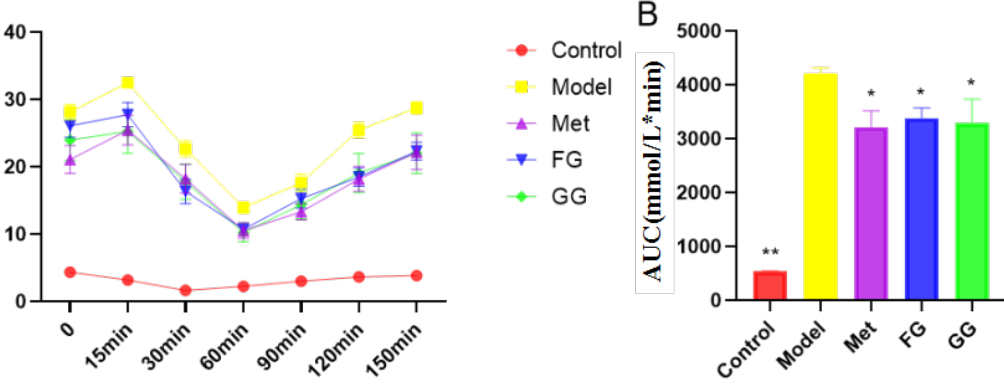
Figure 2. Effects of Pueraria polysaccharide on the glucose tolerance of db/db mice ( n = 10; * p < 0.05; ** p < 0.01 compared with the model group). ( A ) Effect of Pueraria polysaccharide on blood glucose value in db/db mice; ( B ) Effect of Pueraria polysaccharide on AUC in db/db mice.